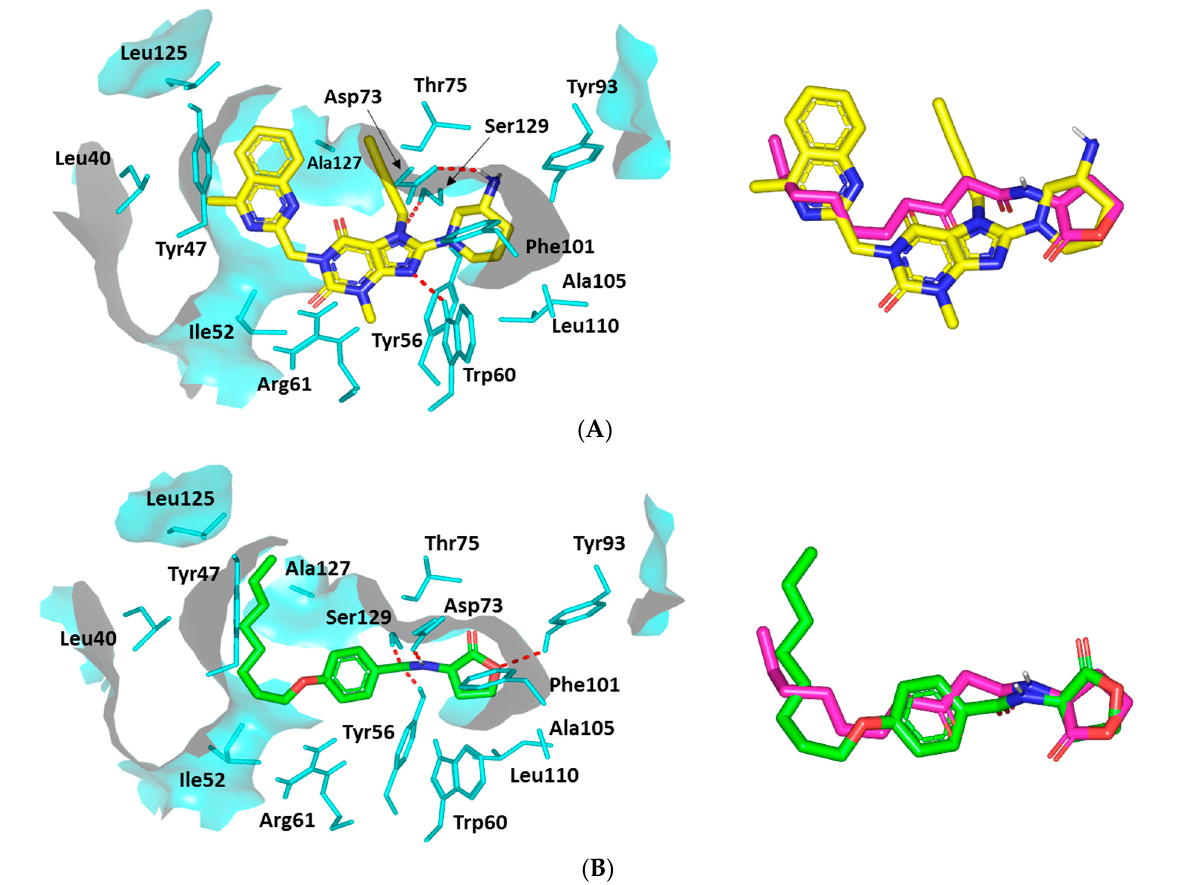
Figure 12. Ligand-protein binding interactions at Pseudomonas aeruginosa LasR quorum-sensing transcription protein binding site. Predicted binding modes of the docked ligands ( A ) LIN and ( B ) Q9 as cyan and green sticks, respectively. Only residues located within 5Å radius of bound ligands are displayed (cyan lines) and labeled with a sequence number. Non-polar hydrogens are removed for clarity and hydrogen bonds are depicted as red dashed lines. The right panels are an overlay of LIN or Q9 with the co-crystalline ligand, 3-O-C10-HSL, as magenta sticks.